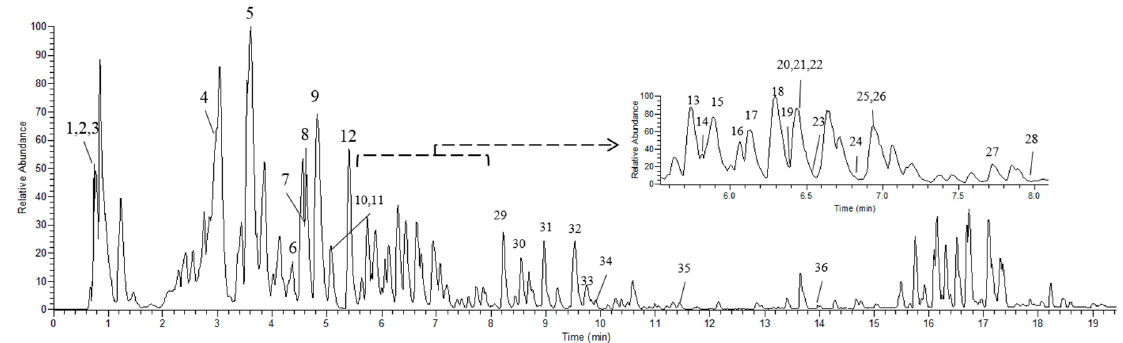
Figure 3. The base peak intensity chromatogram of 70% ethanol solution of the dried ACS extract analyzed by ultra-performance liquid chromatography coupled with electrospray ionization orbitrap mass spectrometry (UPLC-ESI-Orbitrap-MS) in negative ionization mode.